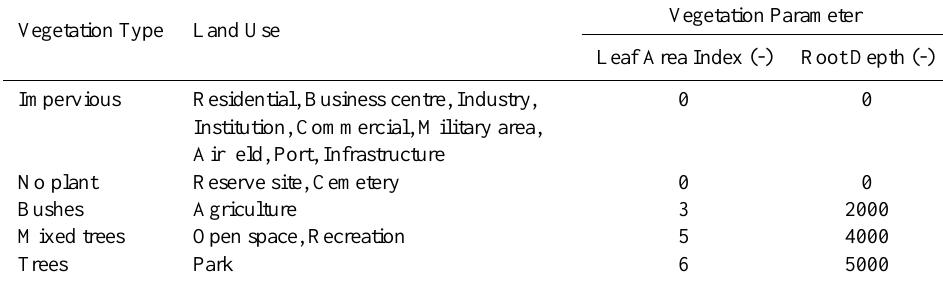
Table 1. Vegetation characteristics.